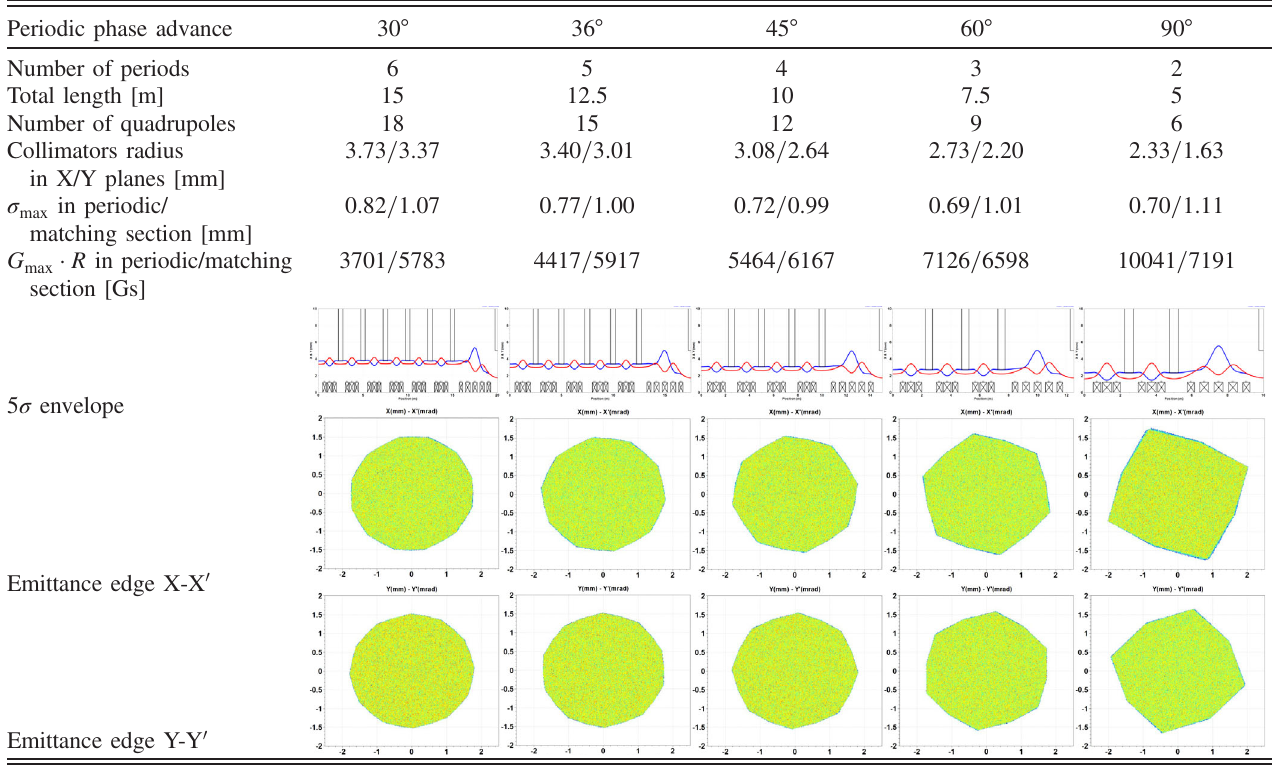
TABLE IV. Comparison of different periodic phase advance in the collimation section for 1.5 GeV beam. Periodic phase